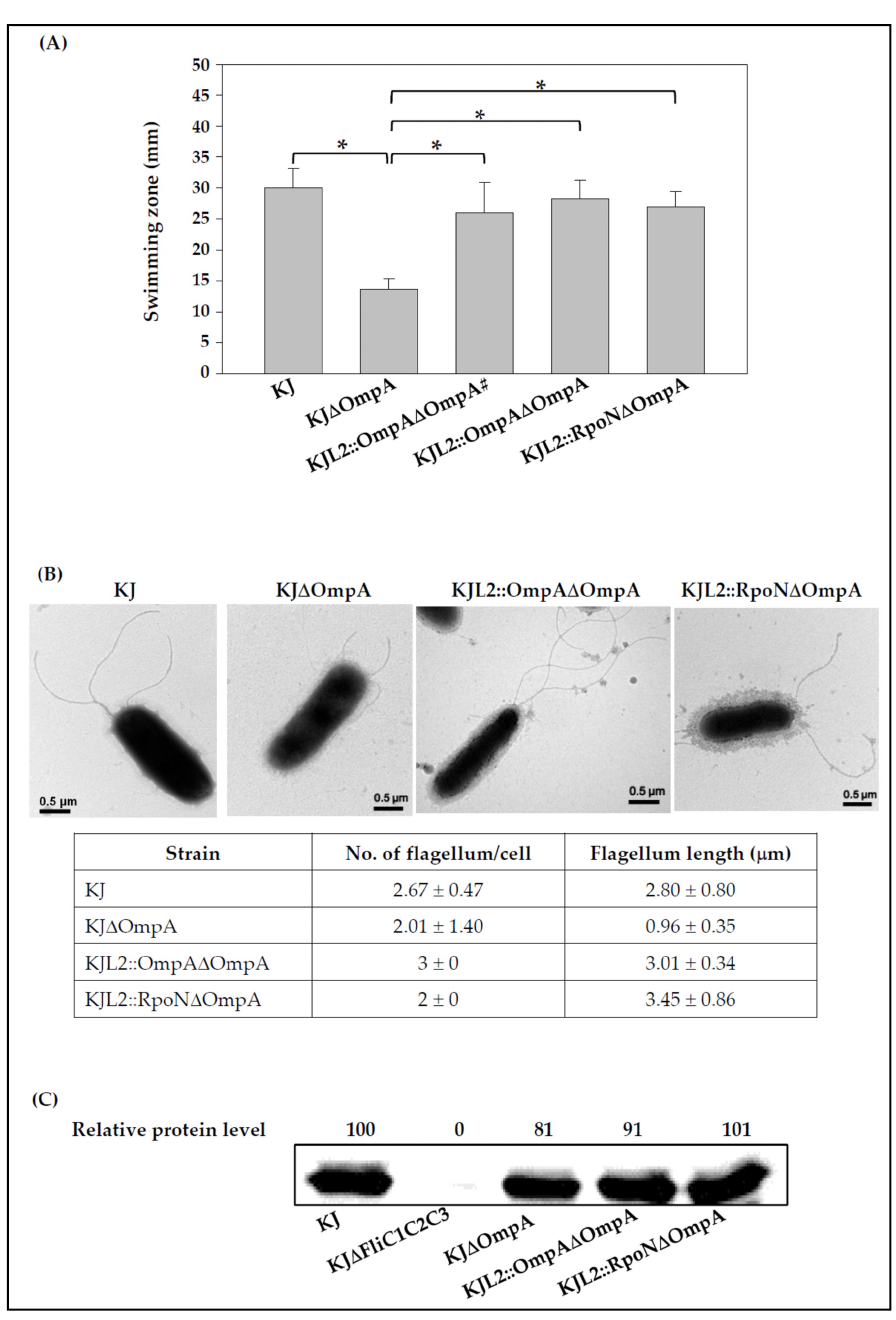
Figure 2. The swimming motility, flagellum morphology, and intracellular flagellin proteins levels of wild-type KJ, its derived ompA mutant, and complementary strains. Overnighted cultured bacterial cells were inoculated into fresh LB broth and then grown for 5 h before testing. ( A ) Swimming motility. Five µL of bacterial cell suspension were inoculated into swimming agar and then incubated at 37 °C for 48 h. The swimming zones were recorded. #, Cefuroxime of 50 µg/mL was added into the swimming agar. The data are the means of three independent experiments. The error bars indicate the standard deviations of three triplicate samples. *, p < 0.05, significance calculated using the Student’s t -test. ( B ) Flagella morphology. The flagella were negatively stained with 1% phosphotungstic acid (pH 7.4) and observed using TEM. The average flagellum numbers per cell and flagellum length were calculated from at least four cells. ( C ) Western blotting of flagellin protein levels in a whole-cell extract. The proteins of a whole-cell extract were separated using SDS-PAGE and immunoblotting with anti-FliC3 and anti-RpoA antibodies. The RpoA protein served as an intracellular control. The relative protein level of the FliC protein was normalized to the RpoA